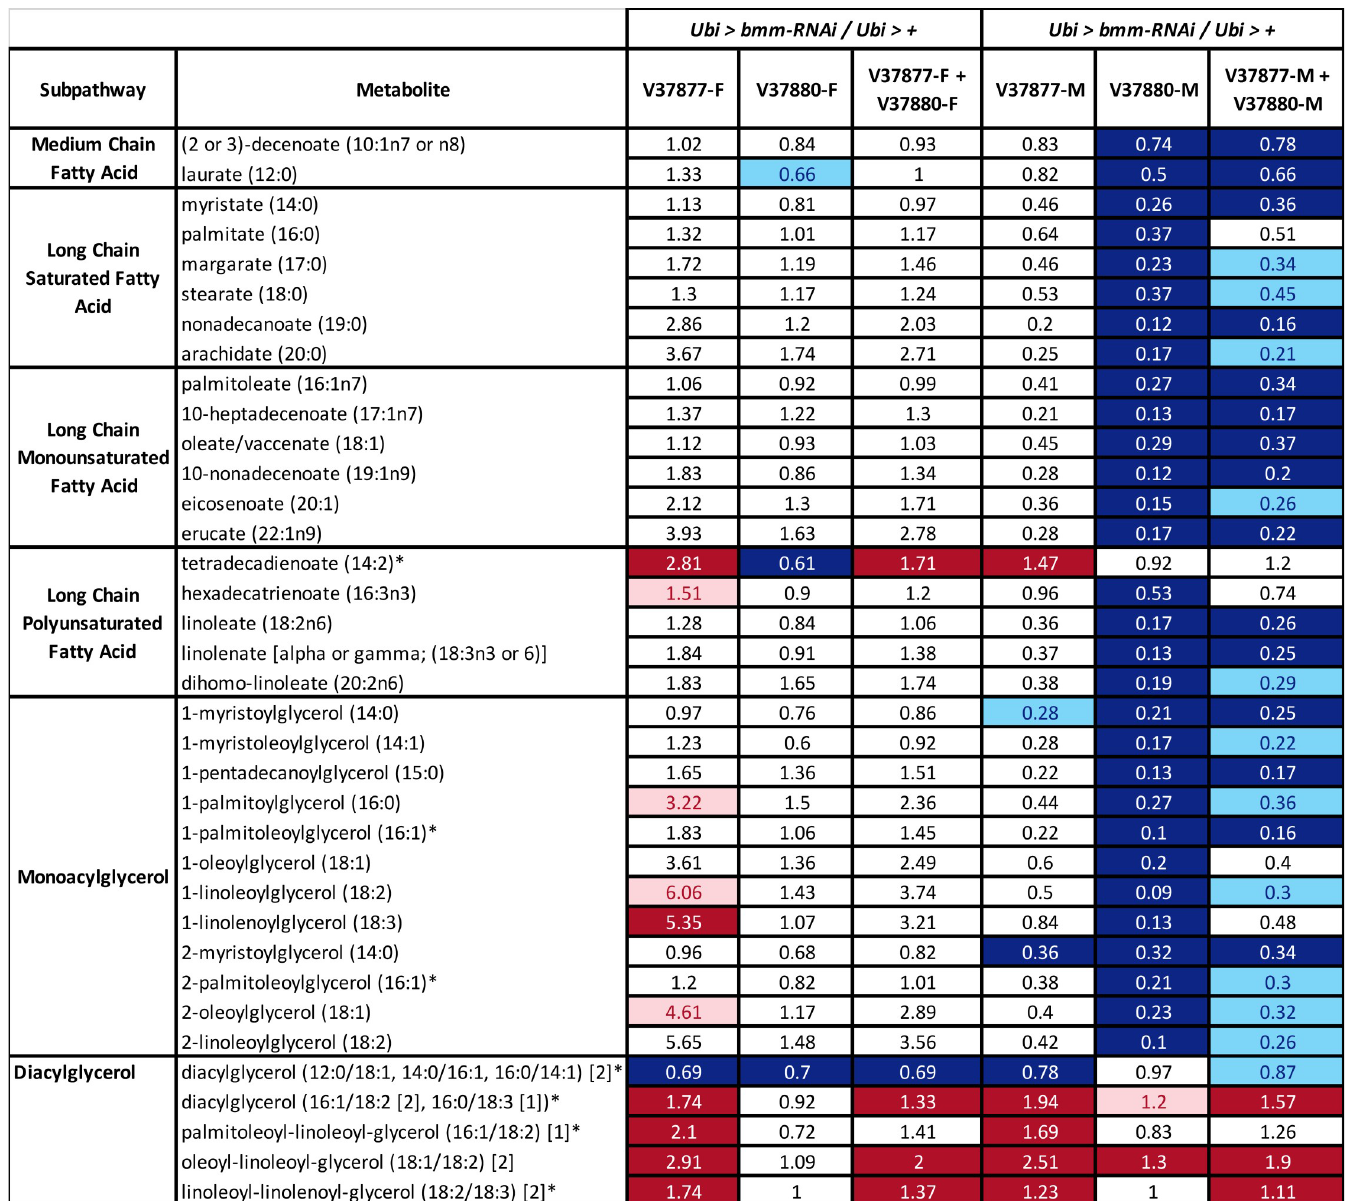
Fig 5. Compounds of lipid metabolism with altered levels of abundance in Ubi > bmm-RNAi flies. Heat map of changes in biochemicals of lipid metabolism in flies in which bmm is downregulated ( Ubi > bmm-RNAi ) compared with control flies ( Ubi > +). For this graph and the graphs below, we performed a single comparison of each strain with its corresponding control for females (V37877-F and V37880-F) and males (V37877-M and V37880-M). Also, we performed a comparison of both strains with their corresponding controls for females (V37877-F + V37880-F) and males (V37877-M + V37880-M). Red and dark blue represent the metabolites that increased and decreased respectively at p � 0.05, light red and light blue represent the metabolites that increased and decreased respectively at 0.05 � p � 0.1 (q-value is reported in S1 Dataset). Asterisks indicate compounds that have not been confirmed based on a